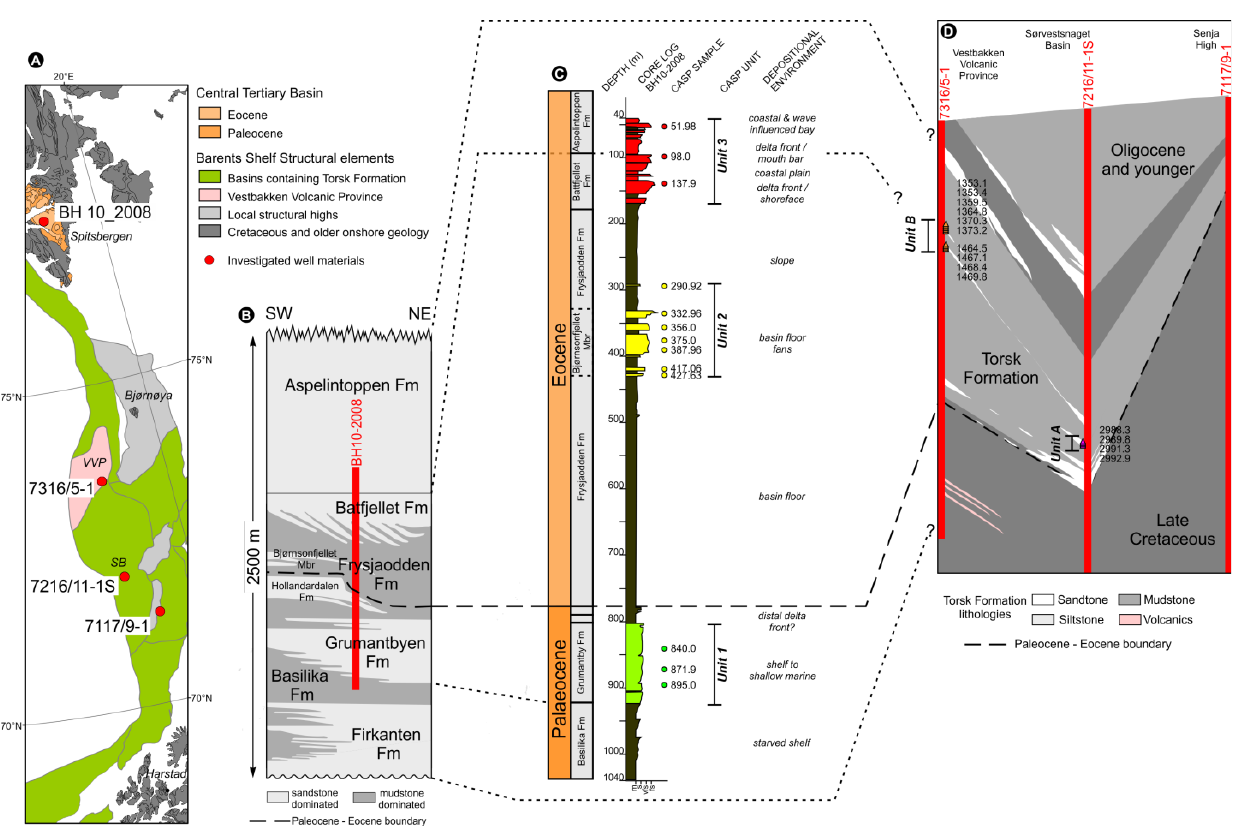
Figure 2. Location and stratigraphy for the investigated samples. ( A ) Map of well locations, relevant structural elements and Central Tertiary Basin outcrop. The Barents Shelf structural elements after Gabrielsen et al. [50] are abbreviated as follows: LH = Loppa High, SB = Sørvestsnaget Basin, SH = Stappen High, VVP = Vestbakken Volcanic Province. ( B ) Central Tertiary Basin stratigraphic cross section adapted from Steel, Dalland, Kalgraff and Larsen [6] shows the BH 10-2008 cored interval. ( C ) Stratigraphic log for well BH 10-2008 after Grundvåg, Johannessen, Helland-Hansen and Plink-Björklund [14], showing the sandstone units and sample locations. ( D ) Torsk Formation cross sections are adapted Ryseth, Augustson, Charnock, Haugerud, Knutsen, Midbøe, Opsal and Sundsbø [20] and Omosanya et al. [51] show the sandstone units and sample locations. The numbers adjacent to the sample symbol indicate the well depth in metres.